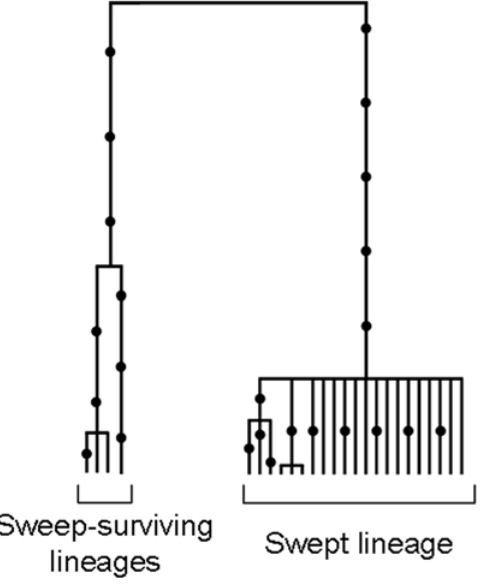
Figure 9. Reconstructed genealogy of the SAHH locus for B. azoricus . Mutations are indicated with dots.